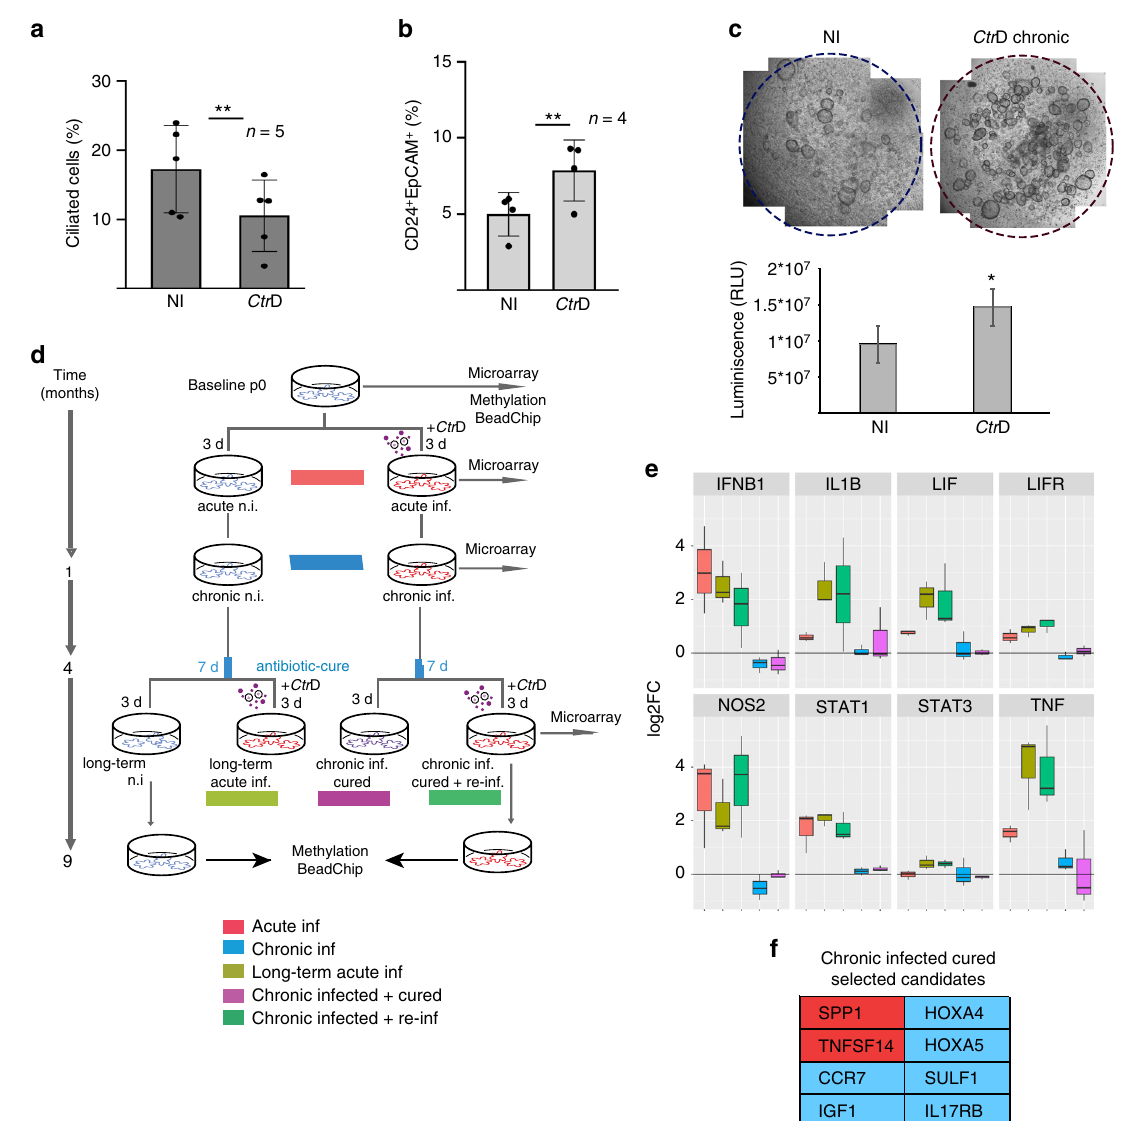
Fig. 3 Chronic Ctr infection leads to fewer ciliated cells, increased stemness markers and downregulation of immunomodulators. a Chronic infection (>3 months) signi fi cantly reduces the number of ciliated cells in the organoids. Percentage of ciliated cells was calculated as the number of ciliated cells per nuclei per fi eld of view. Data represent mean ± SD from fi ve independent experiments; dot plot re fl ects data points from independent infections ** p = 0.0059, paired Student ’ s t -test. b Chronically infected organoids show increased numbers of CD24 + /EpCam + cells, as determined by FACS pro fi ling. Data represent mean ± SD of four independent chronic infections. Data points from independent experiments are represented on dot plot. ** p =